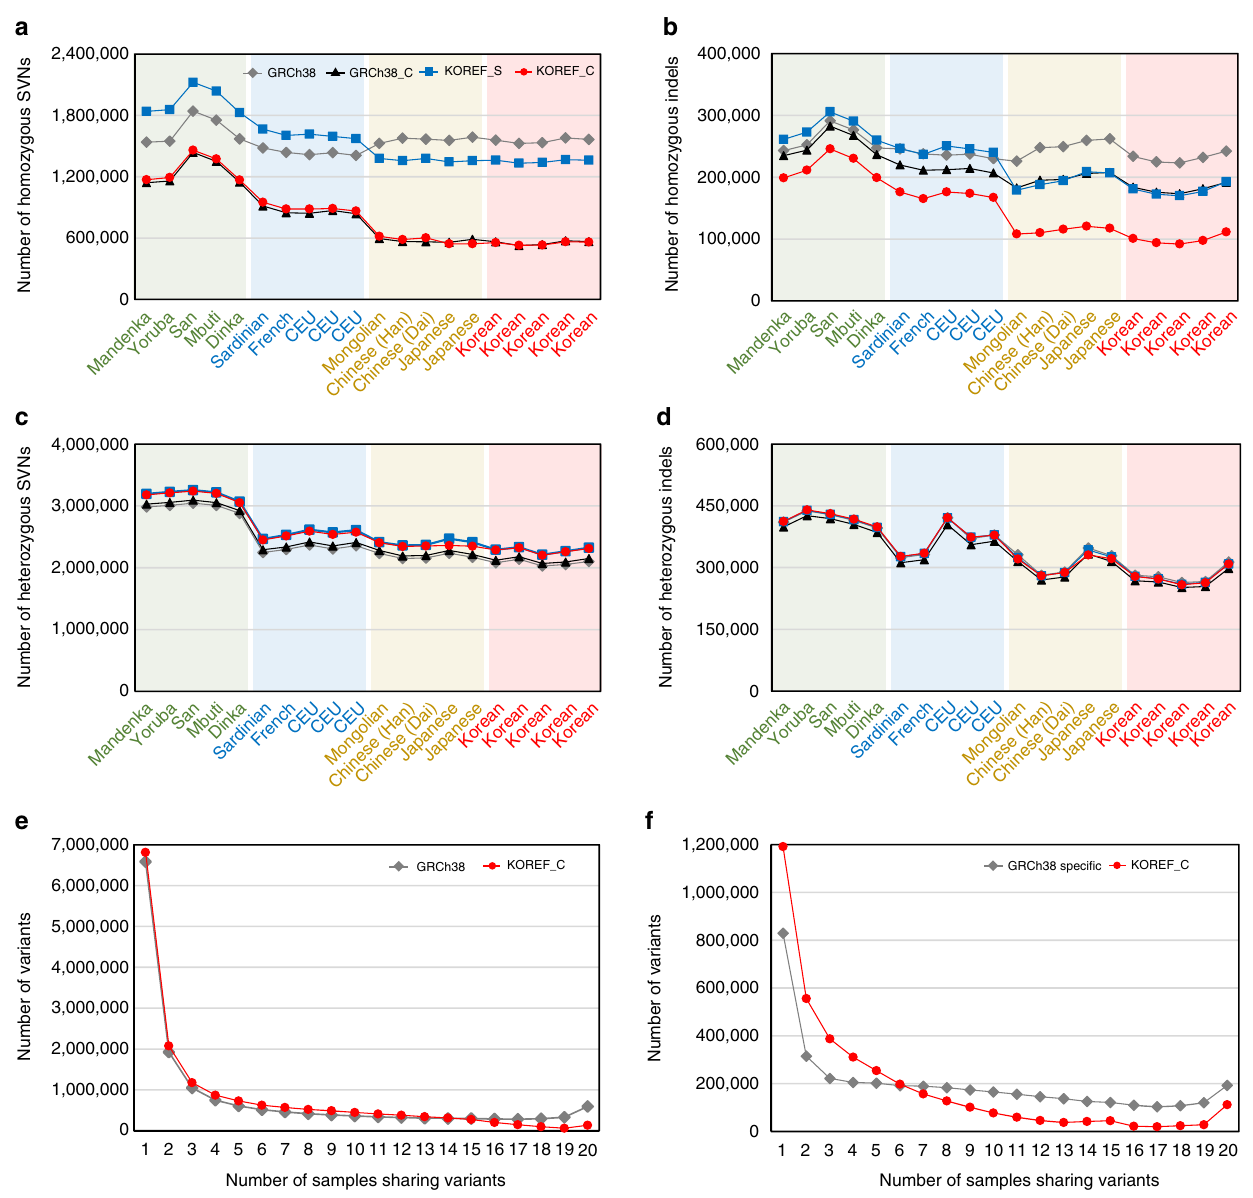
Figure 3 | Variants difference depending on the reference genome. Variants (SNVs and small indels) numbers within the regions shared by KOREFs, GRCh38 and GRCh38_C were compared using whole-genome re-sequencing data from three different ethnic groups (Africans: Mandenka, Yoruba, San, Mbuti and Dinka; Caucasians: Sardinian, French and three CEPH/Utah (CEU); East-Asians: Mongolian, two Chinese, two Japanese and five Koreans). ( a ) Number of homozygous SNVs. ( b ) Number of homozygous small indels. ( c ) Number of heterozygous SNVs. ( d ) Number of heterozygous small indels. ( e ) The number of variants (referenced by GRCh38 and KOREF_C) at different levels of sharedness. ( f ) The number of reference-specific variants at different levels of